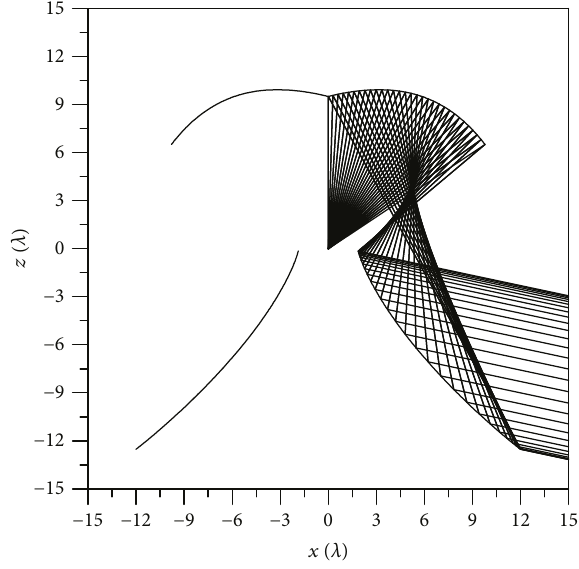
Figure 5: Generatrices and ray tracing of the shaped omnidirectional ADE